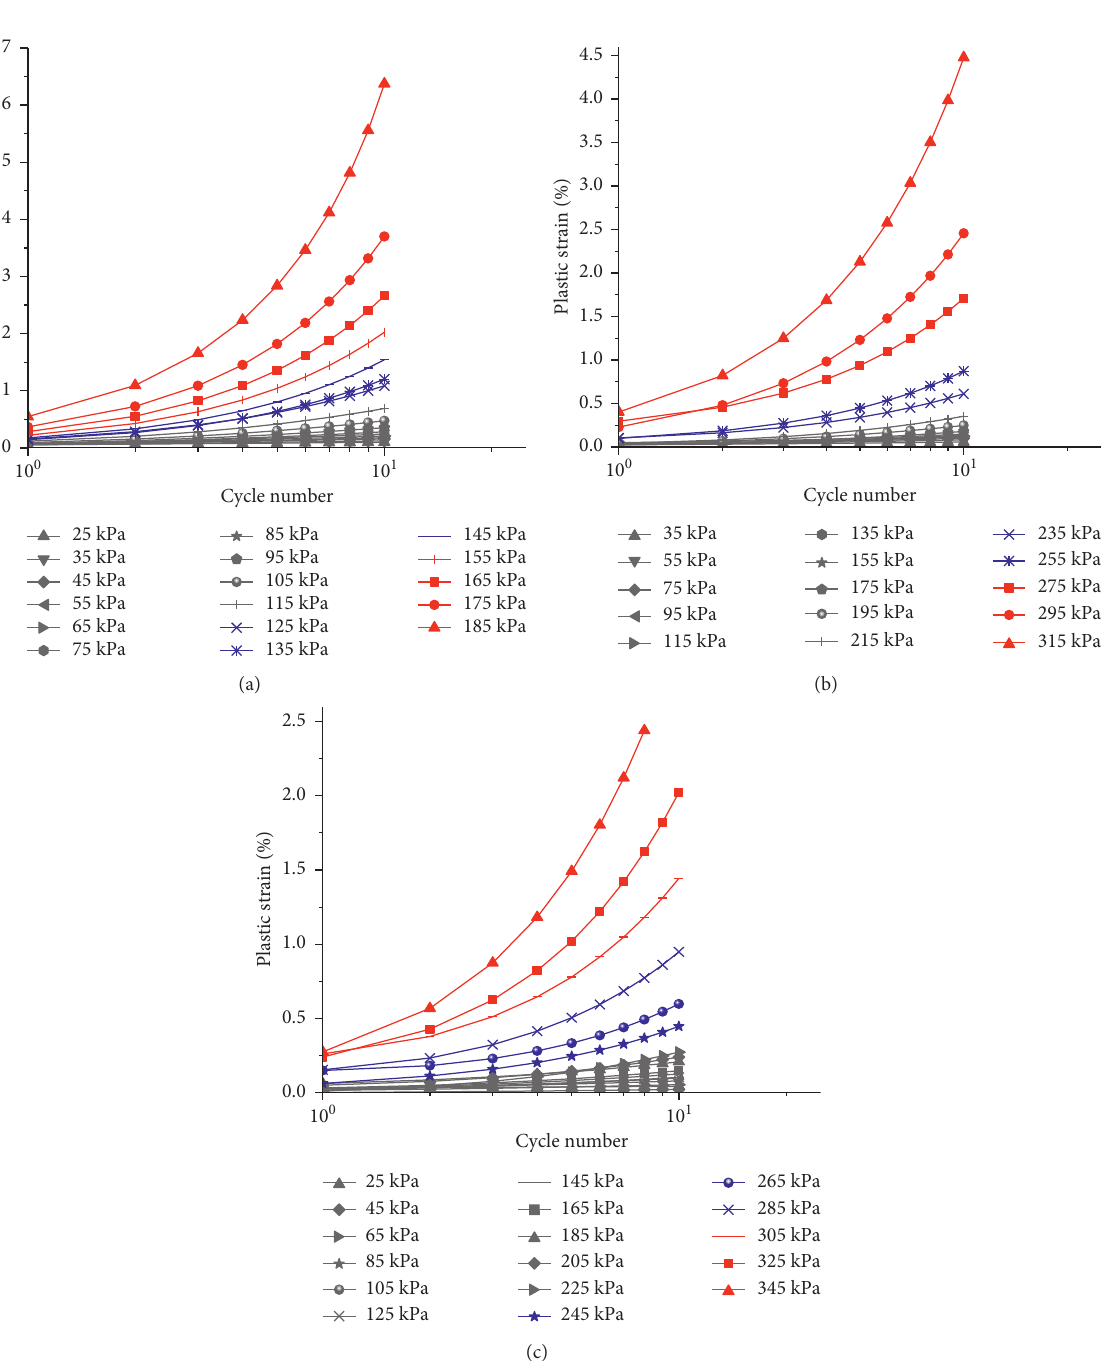
Figure 7: Curves of cumulative plastic strain versus cycle number for different frequencies. (a) 0.5 Hz. (b) 1Hz. (c)